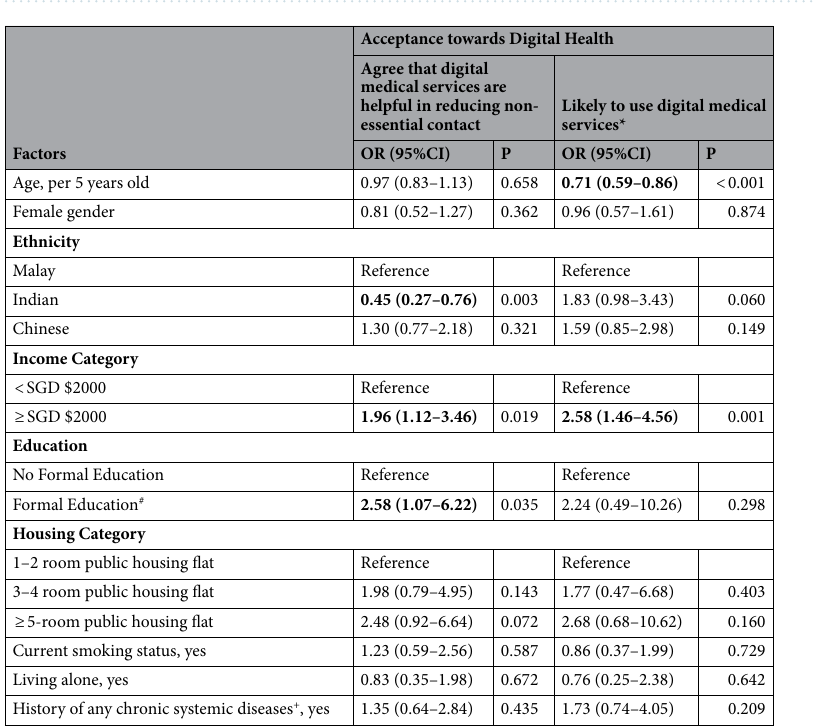
Figure 3. Respondents’ familiarity, attitude and acceptance towards the digital health services or technologies.